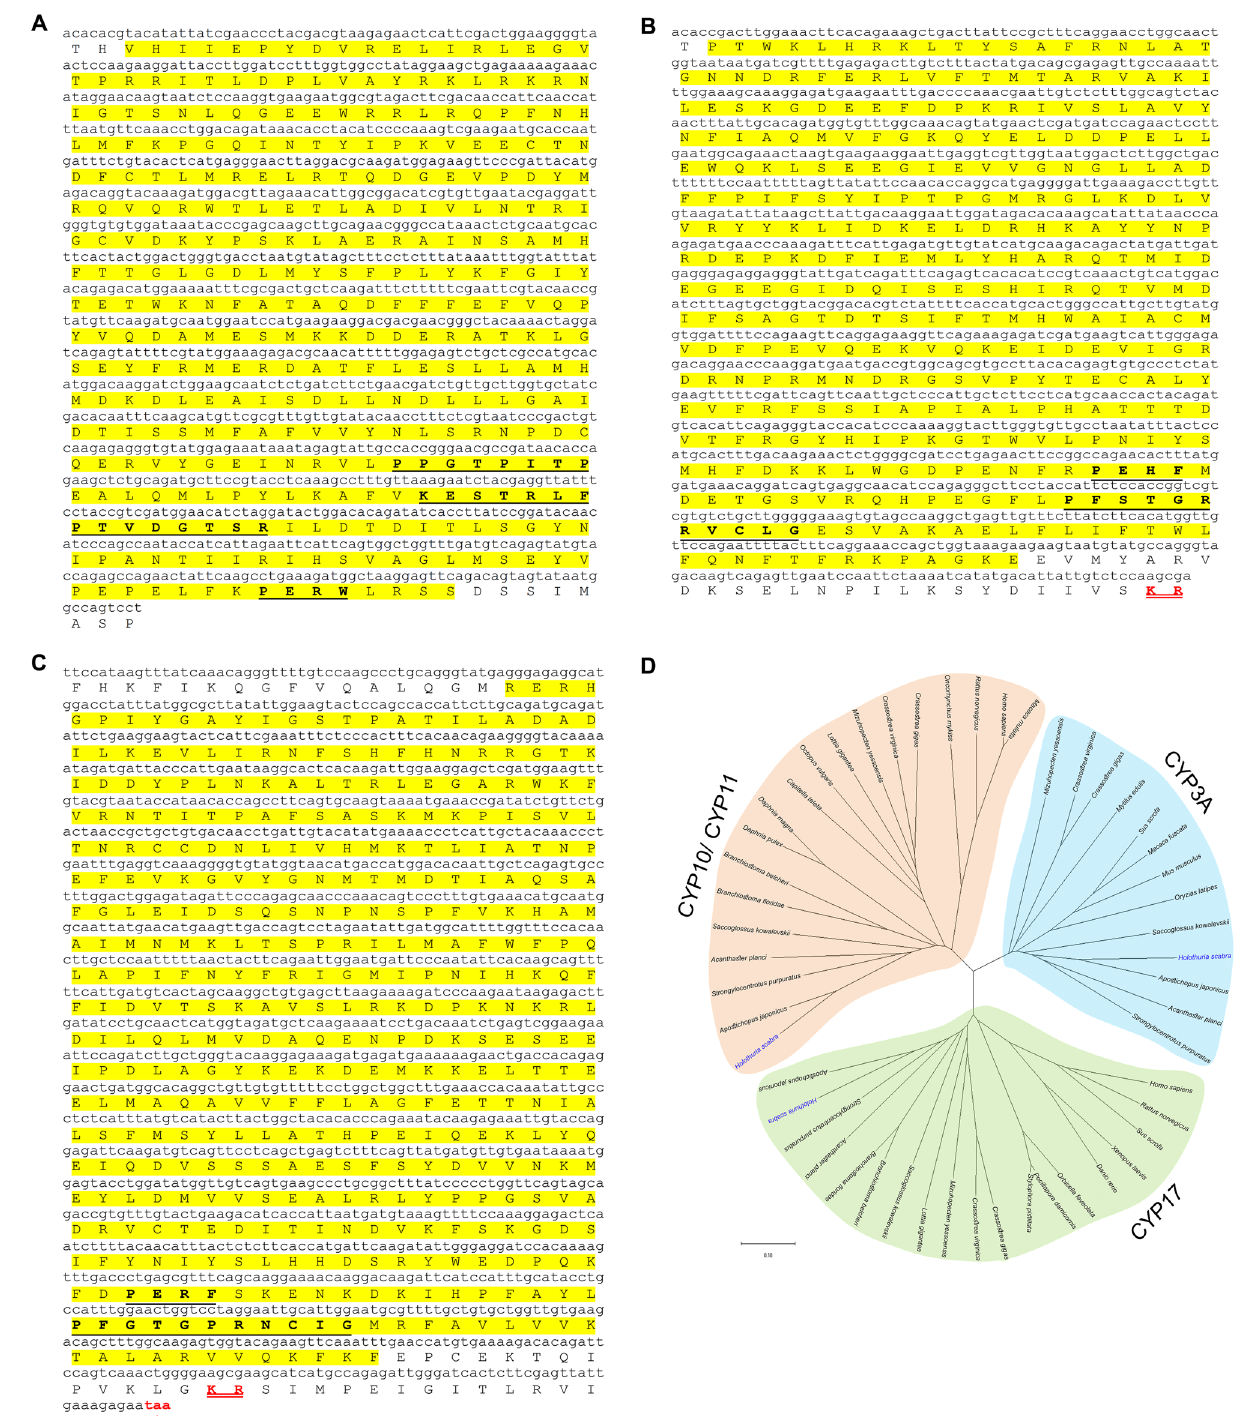
Figure 4. Characterization and phylogenetic tree analysis of H. scabra cytochrome P450 genes associated with steroidogenesis. ( A ) HscCYP10 contains the cytochrome P450 domain (yellow highlight) that includes a proline-rich motif (PPGTPITP), PERF/W, and KET/S(x)R(x)P(x)R regions (bold underlined letters). ( B ) HscCYP17 showed cytochrome P450 domain (yellow highlight) contains the heme-binding region (PFSTGRRVCLG) and PEHF region (bold underlined letters), and cleavage site (red double-underlined letters). ( C ) HscCYP3A contains cytochrome P450 domain (yellow highlight), which consists of PERF and heme- binding (PFGTGPRNCIG) regions (bold underlined letters), cleavage site (red double-underlined letters), and stop codons (red letters). ( D ) Phylogenetic tree of target CYP 450 involved in steroidogenesis constructed based on Neighbour-joining analysis with 1000 replicates bootstrap. Scale bar represents amino acid differences. Amino acid sequences and their accession number are shown in